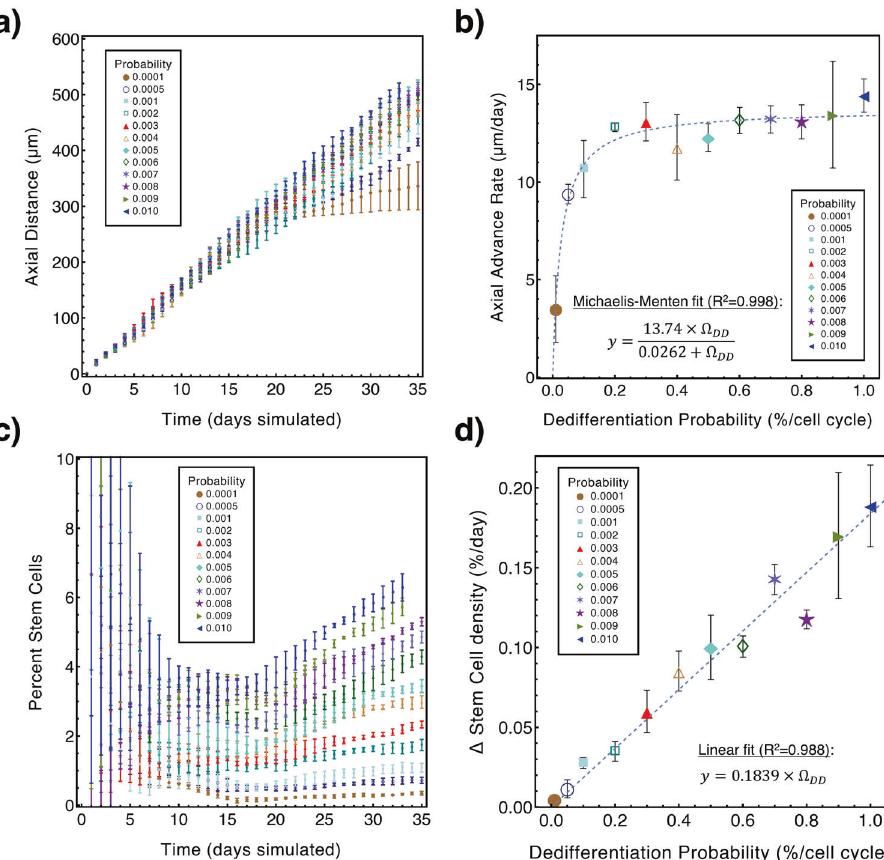
Fig. 5 Local sensitivity analysis of dedifferentiation effects on axial advance rate and stem cell population. a DCIS axial distance per day shows reduced axial advance at lower dedifferentiation probabilities examined after progenitor mitosis cycle limits are fi rst encountered ( t = 15 days), while higher dedifferentiation probabilities support consistent advance rates. b Average axial advance rate after start of dedifferentiation ( t ≥ 15 days) was determined via linear regression analysis of data shown in a ; values are listed in Supplementary Table S2. Michaelis-Menten best fi t to data in b was found to be axial advance rate = (13.74 × Ω DD )/(0.0262 + Ω DD ) µm/day and is shown (blue, dashed; R 2 = 0.998, p < 0.001). c Density of stem cells in the total DCIS population; note that at early times, stochastic proliferation results in